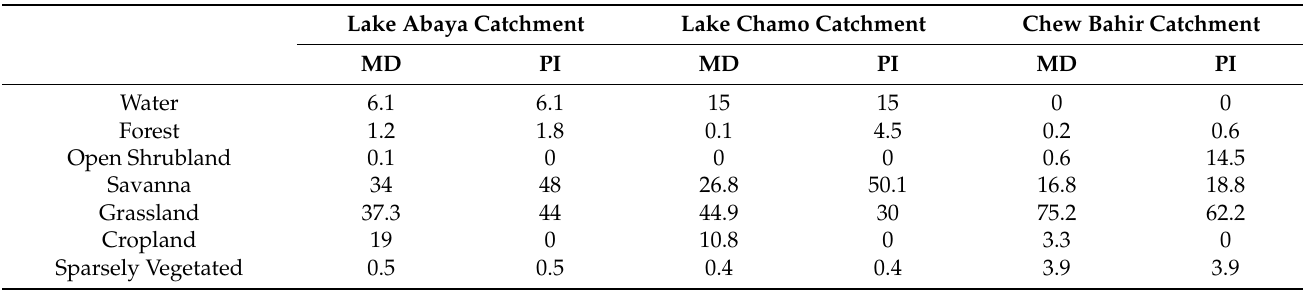
Table 5. Modern-day (MD) and pre-industrial (PI) landcover distribution (%) in the catchments of lakes Abaya, Chamo and paleo-lake Chew